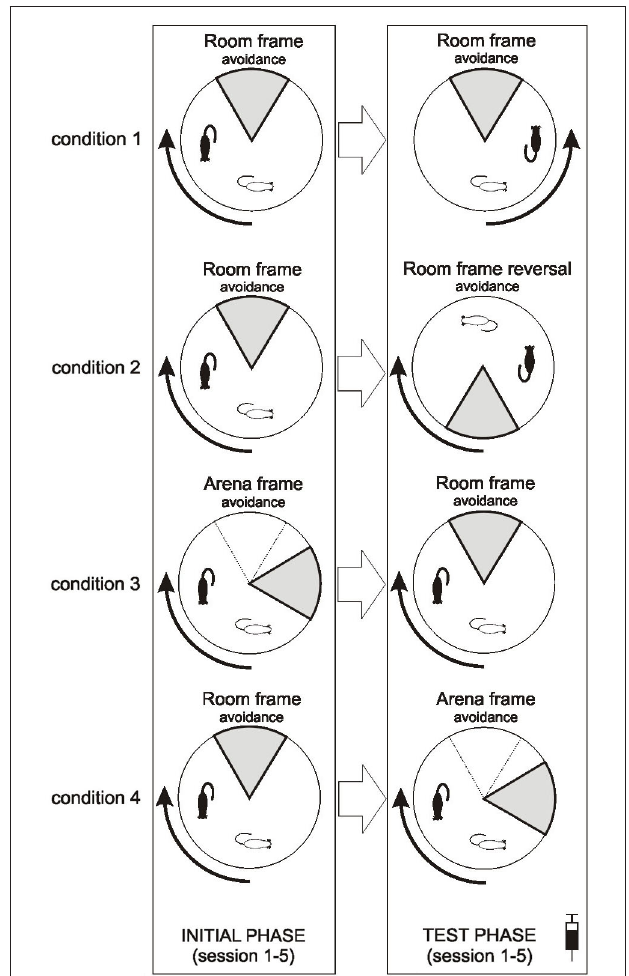
FIGURE 1 | Scheme of behavioral protocol of all four conditions employed . Note that injections (saline or MK-801) were applied only prior to sessions in the test phase. To indicate mutual relationship of the sector and the rotating arena in each condition, position of an immobile rat and the to-be-avoided sector is shown for a time t at the beginning of the session (thin outlines) and t + 15 s (bold outlines). Note that the position of the sector remains fixed during the Room frame avoidance but rotates during the Arena frame